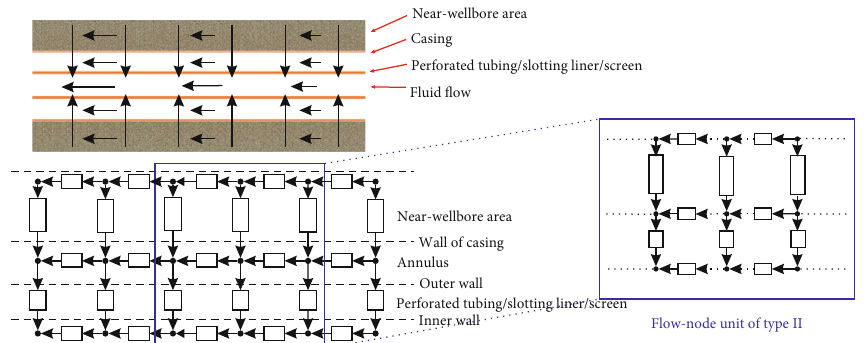
Figure 2: Schematic diagram of completion node with